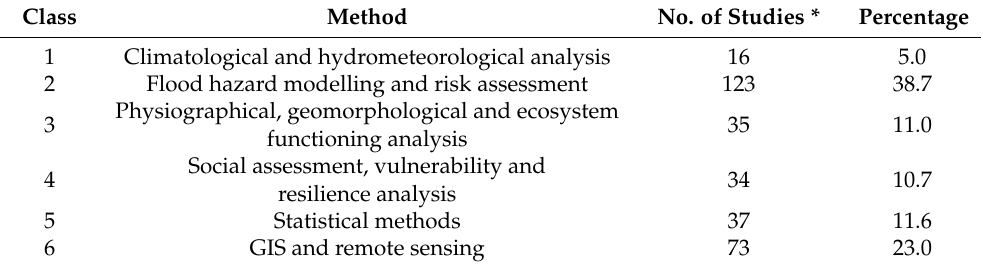
Table 6. Ranking of the surveyed articles based on the methodology